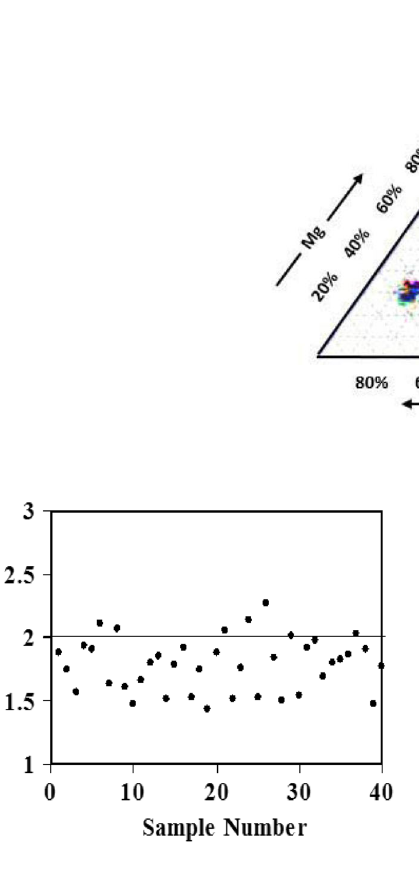
Fig. 3 The scatter diagram of Ca/Mg molar ratio. Ca/Mg = 1 dolomite weathering, Ca/Mg [ 1 Calcite weathering, Ca/Mg [ 2 silicate weathering